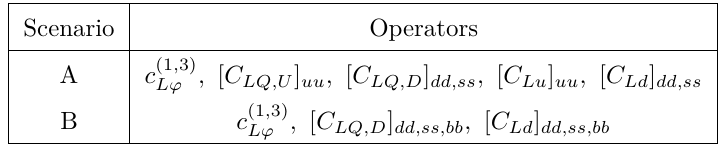
(cid:1) SRR − SRL eτbb ) to τ → eγ . TRR eτuu